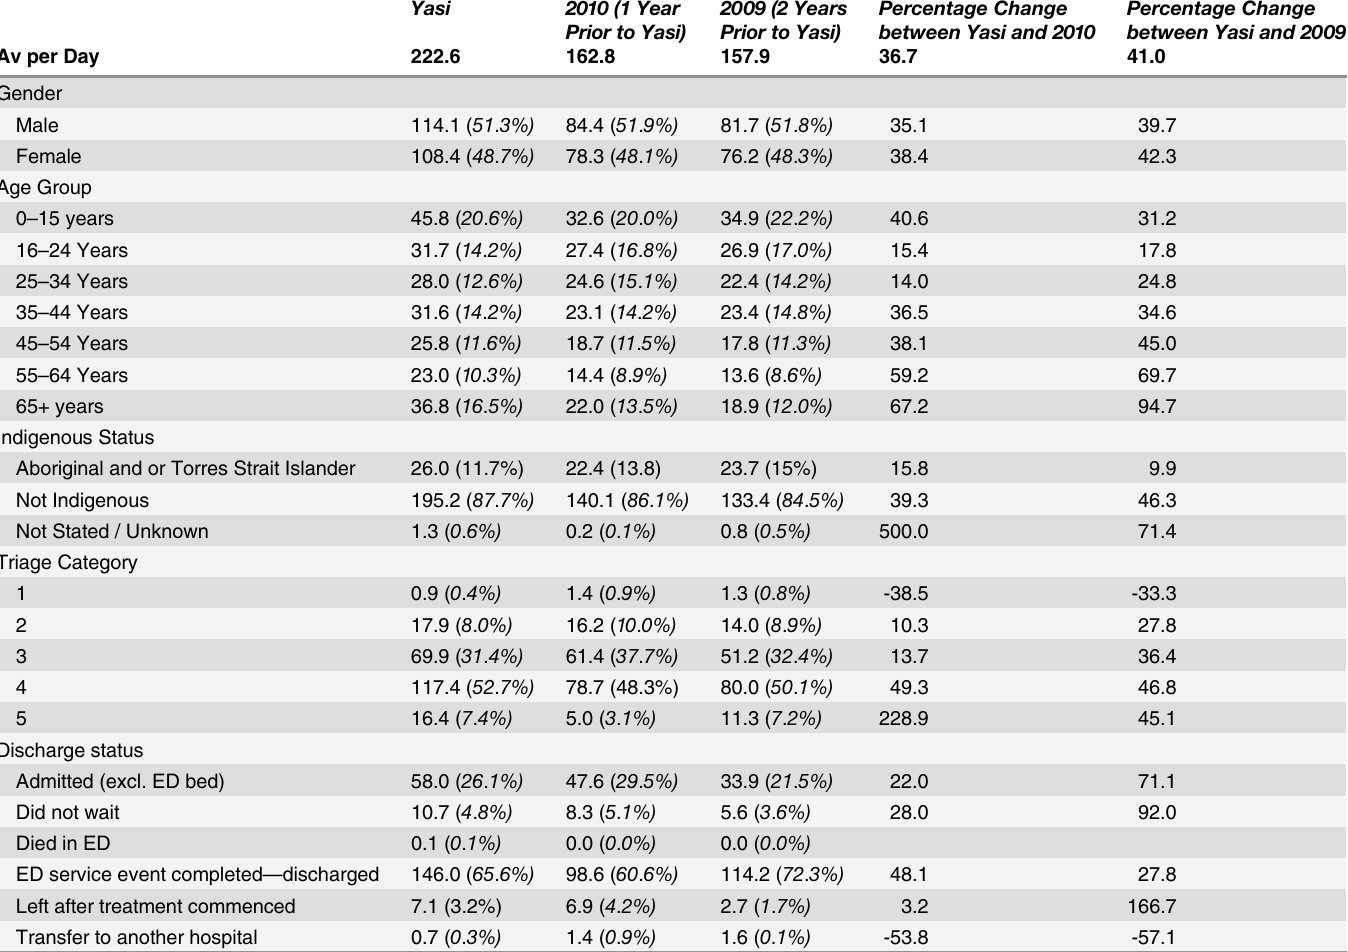
Table 2. Average presentation per day during Yasi and years prior by gender, age, indigenous status, triage category and discharge status, 31-Jan-2011 to 8-Feb-2011, TTH